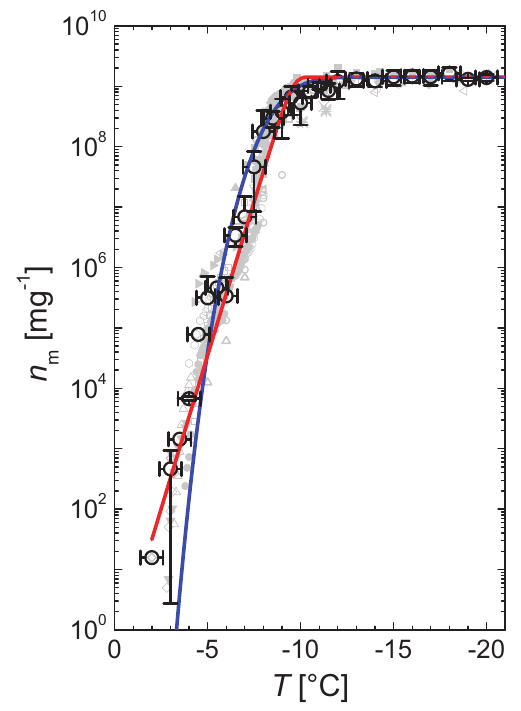
Figure 12. Average n m values (black circles) overlying all sep- arate data points which were included in the average (shown as background in light grey), together with fits obtained from a time- independent variant of the parameterization given in Hartmann et al. (2013) (red curve, see Eq. 6) and in Niedermeier et al. (2014) (blue